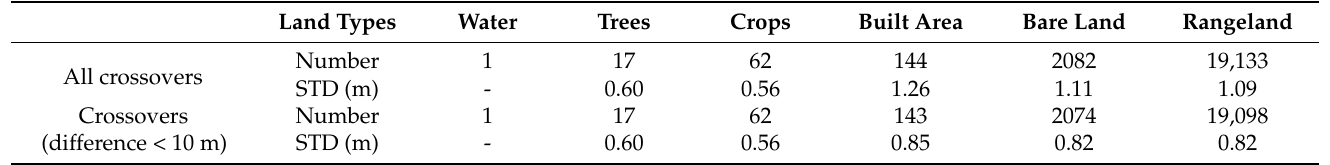
Table 8. Accuracy statistics of crossover difference in different land cover